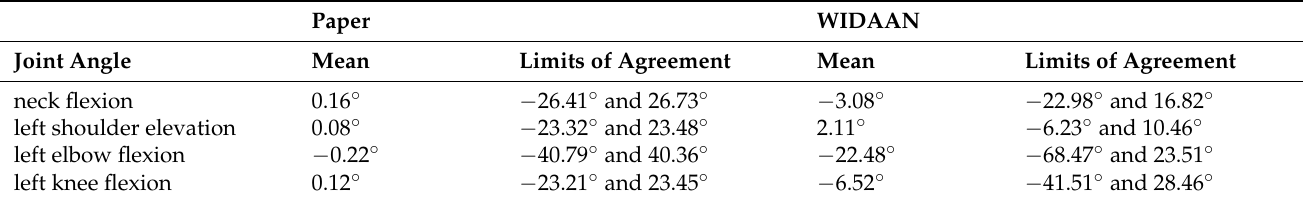
Table 6. Comparison of paper results with WIDAAN results for tracker configuration 9